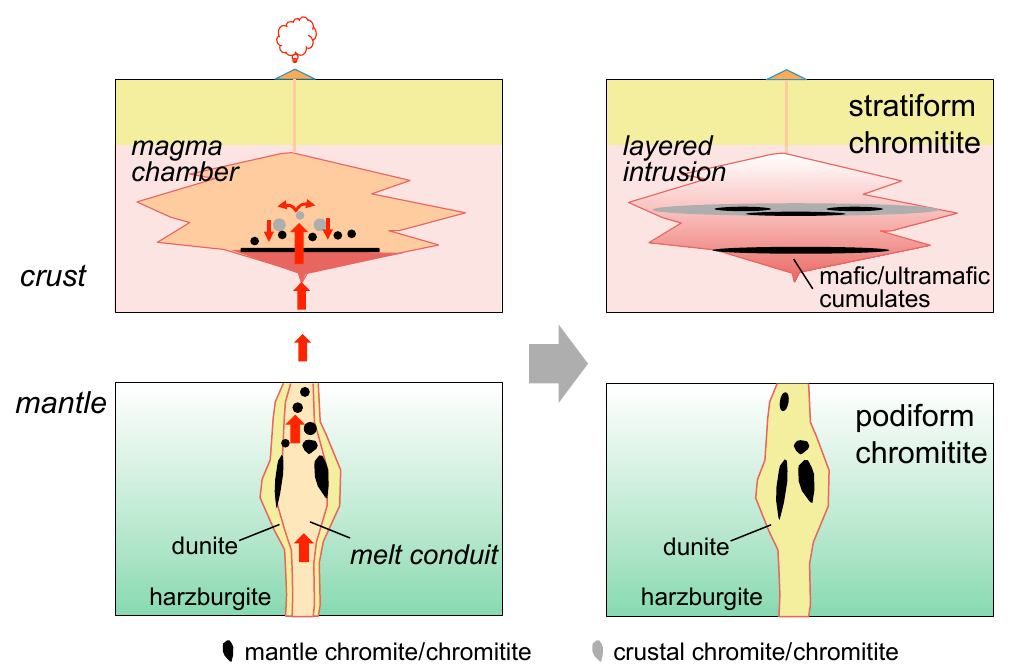
Figure 5. Cartoon to indicate a possible linkage of the crustal stratiform chromitite to the mantle podiform chromitite. Young chromitites generated along a magma conduit (=the podiform chromitite) in the mantle were disintegrated by the subsequently supplied magma and transported as suspended chromite grains up to a crustal magma chamber. They were ultimately re-precipitated and contributed to form part of the stratiform chromitite.